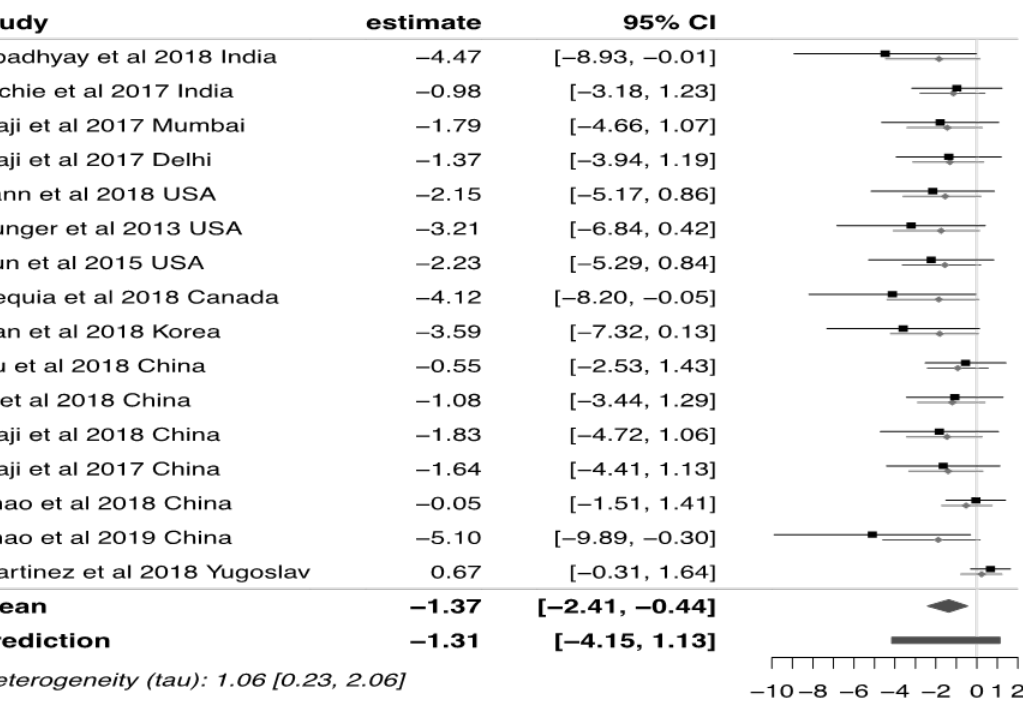
Figure 4. Forest plot PM2.5. The values of the forest plots indicate the log mortality rate mapped to their corresponding normal distribution values.